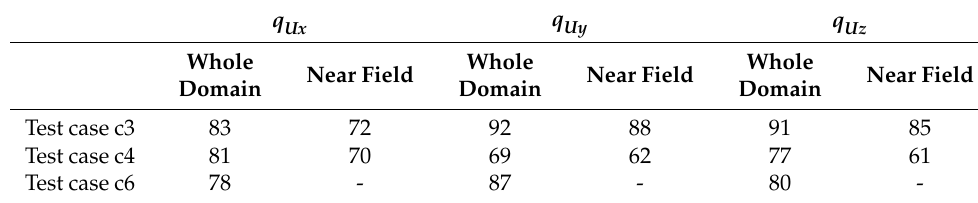
Table 2. Hit ratio in % for all three test